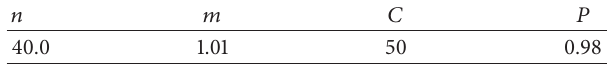
Table 2: The parameter value of creep damage model at 900 ∘